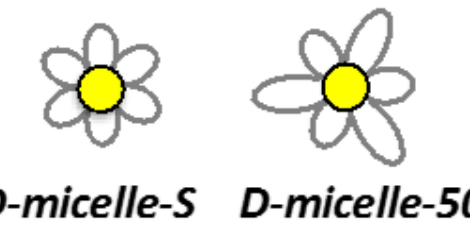
Figure 7. Schematic illustration of D-micelles with mixed PEG block length.